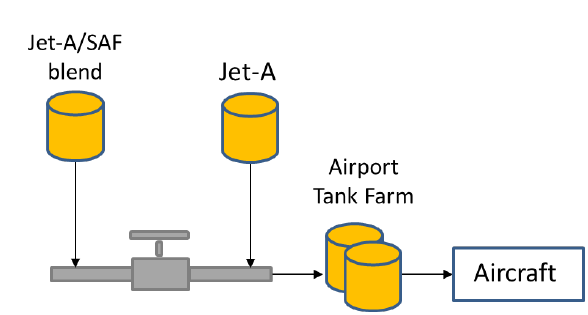
Fig. 14. Second option of Jet-A and SAF blending at the terminal [41] Due to the fact that SAF meet the same standards as conventional jet fuel, specified by ASTM, therefore the problems with compatibility are not excepted